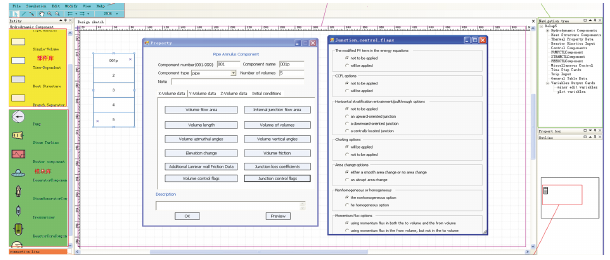
Figure 5: Main interface of RELAP5-MV.